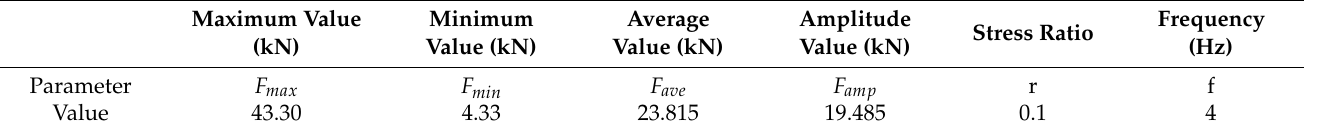
Table 6. Loading data of fatigue test.